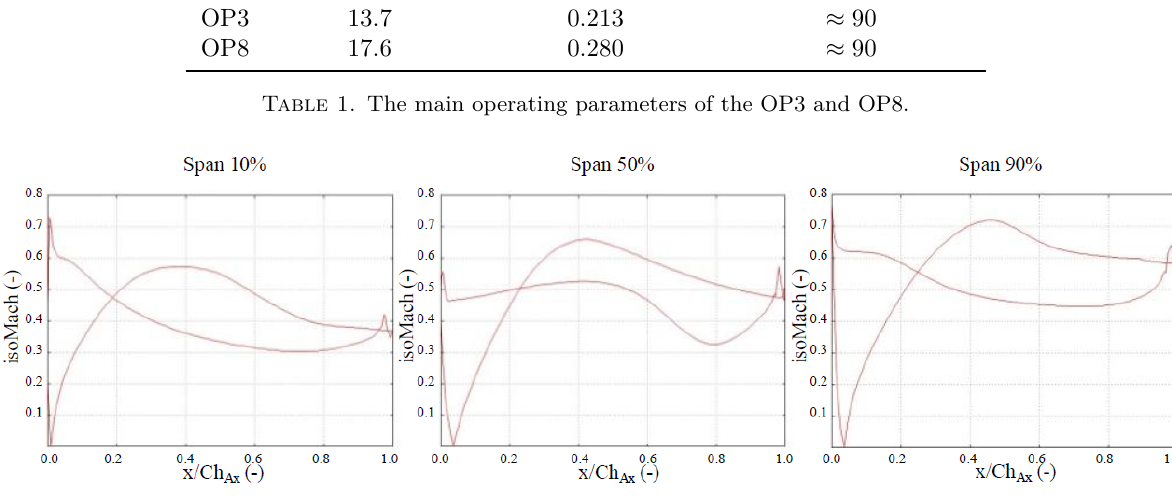
Figure 2. OP3 and OP8 operating parameters and last stage blade loading at 10%, 50% and 90% span for the analyzed volume